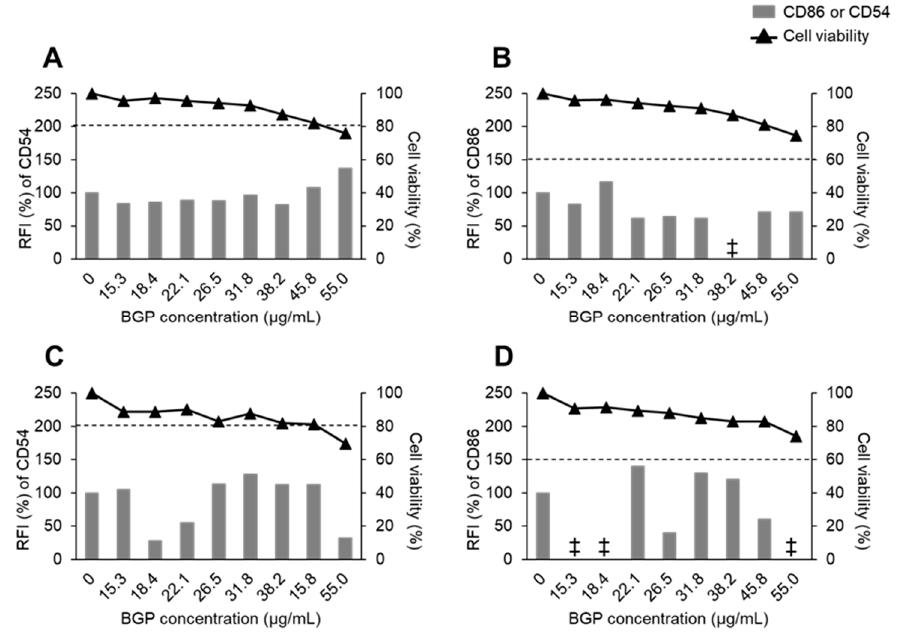
Figure 2. Viability of and expression of CD54 and CD86 on the cell surface of THP-1 cells treated with Brazilian green propolis (BGP). The expression of CD54 ( A , C ) and CD86 ( B , D ) was measured by flow cytometry, and the relative fluorescence intensity (RFI) values were calculated from the data. First experiment ( A , B ) and second experiment ( C , D ) were conducted independently, and data at each concentration were obtained from a single culture. Dashed lines indicate RFI values of 200% (CD54) or 150% (CD86). ‡: RFI < 0.